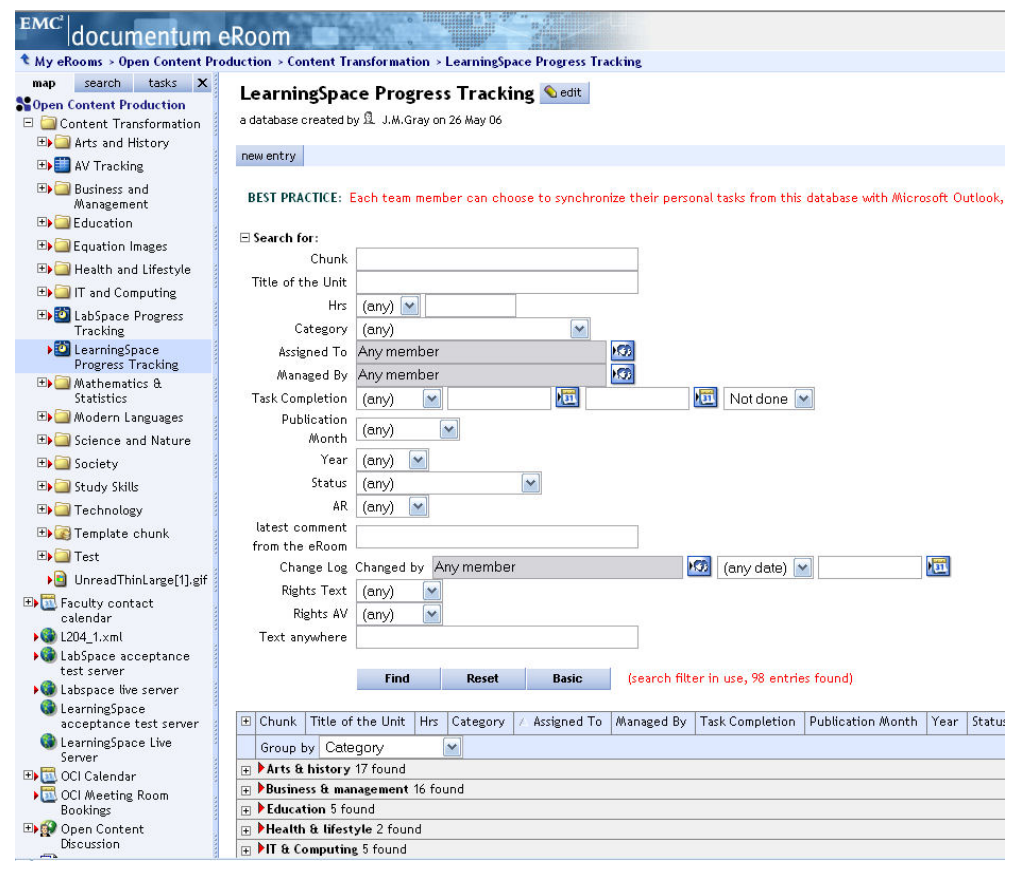
Figure 5 . The OpenLearn Documentum eRoom progress tracking